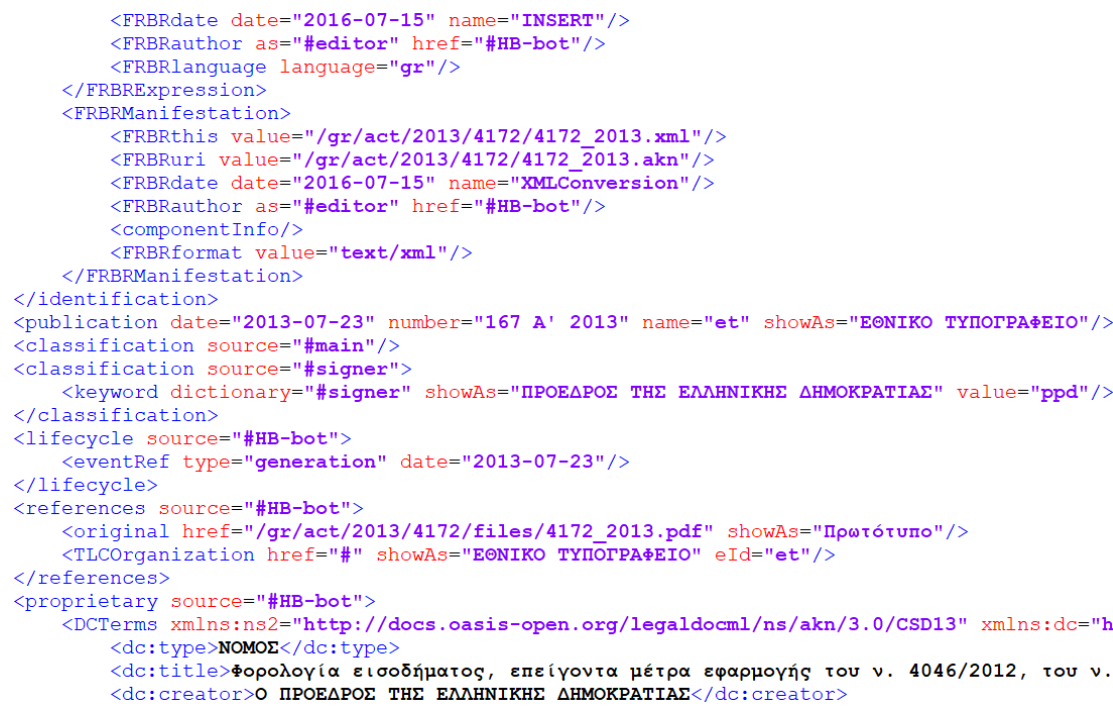
Figure 3. Part of metadata for law 4172, year 2013, annotated following LegalDocML